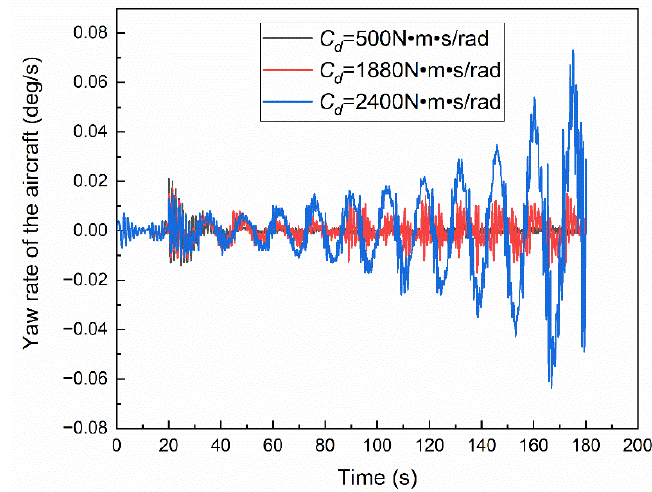
Figure 6. Effect of torsional damping on aircraft yaw rate.